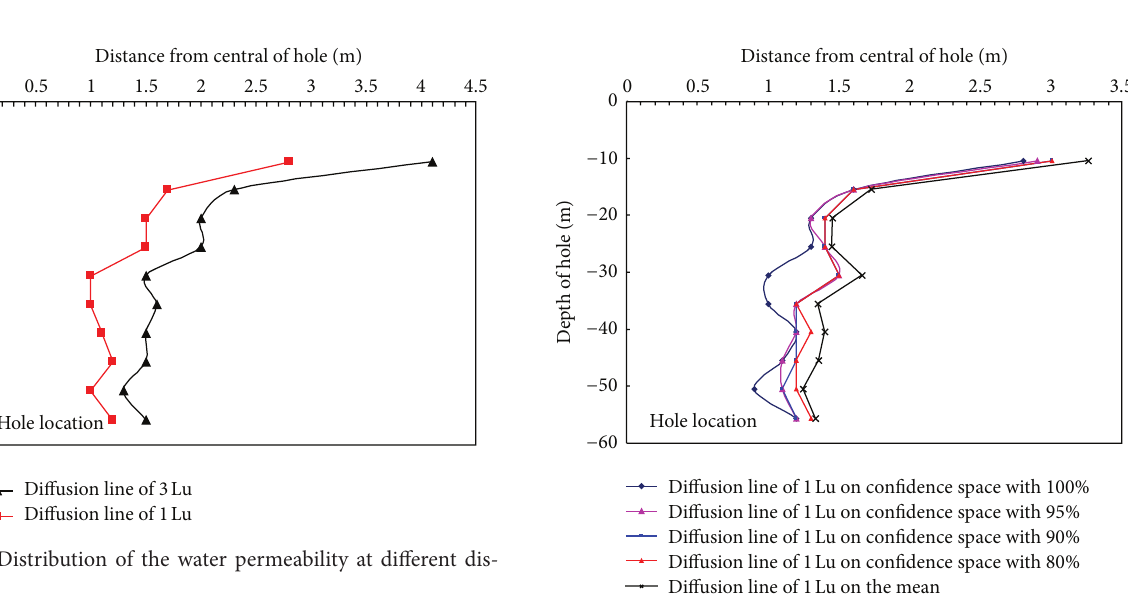
Figure 6: Probability of the distance in each grouting stage with permeability rate less than